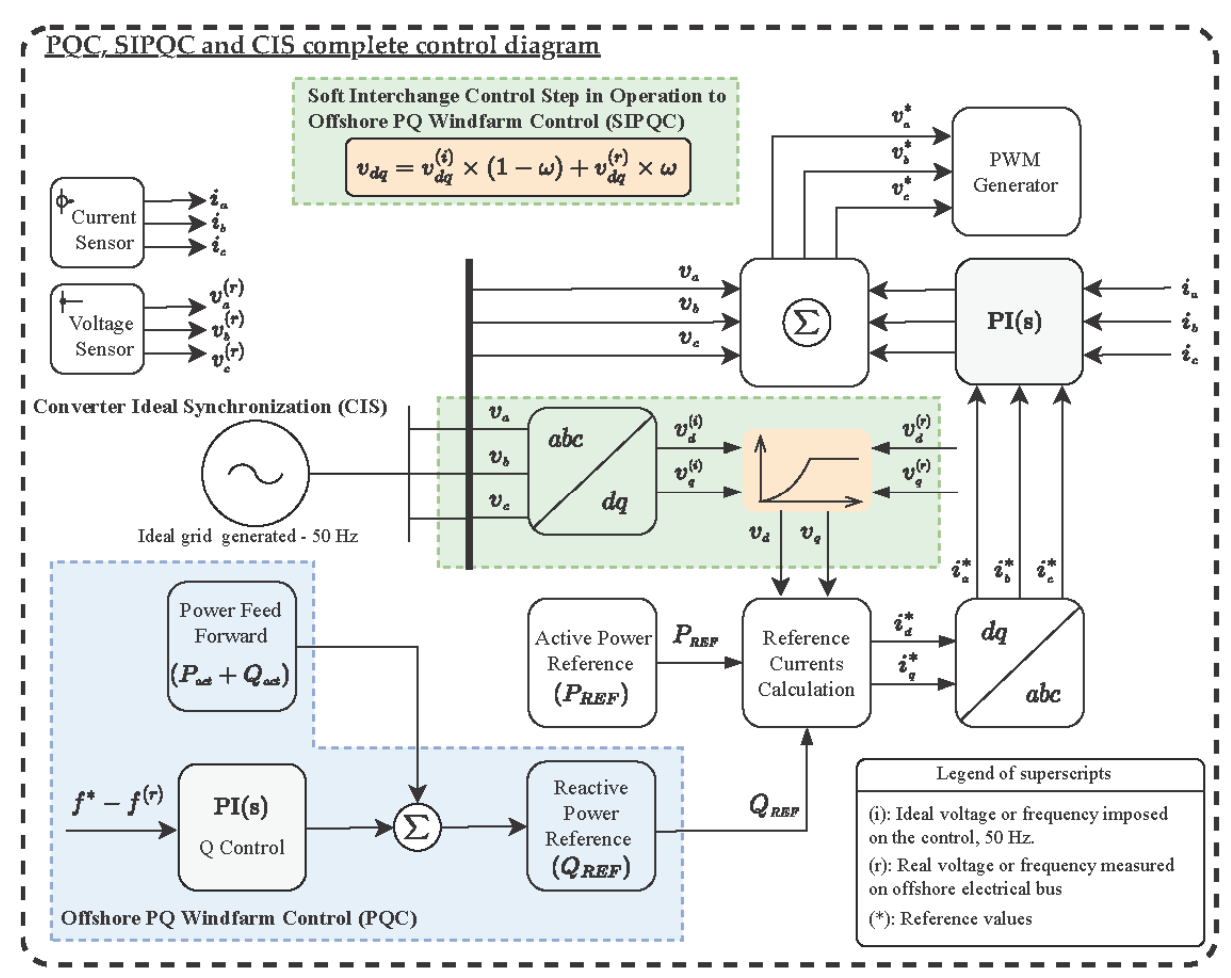
Figure 7. PQC, SIPQC, and CIS control diagram.